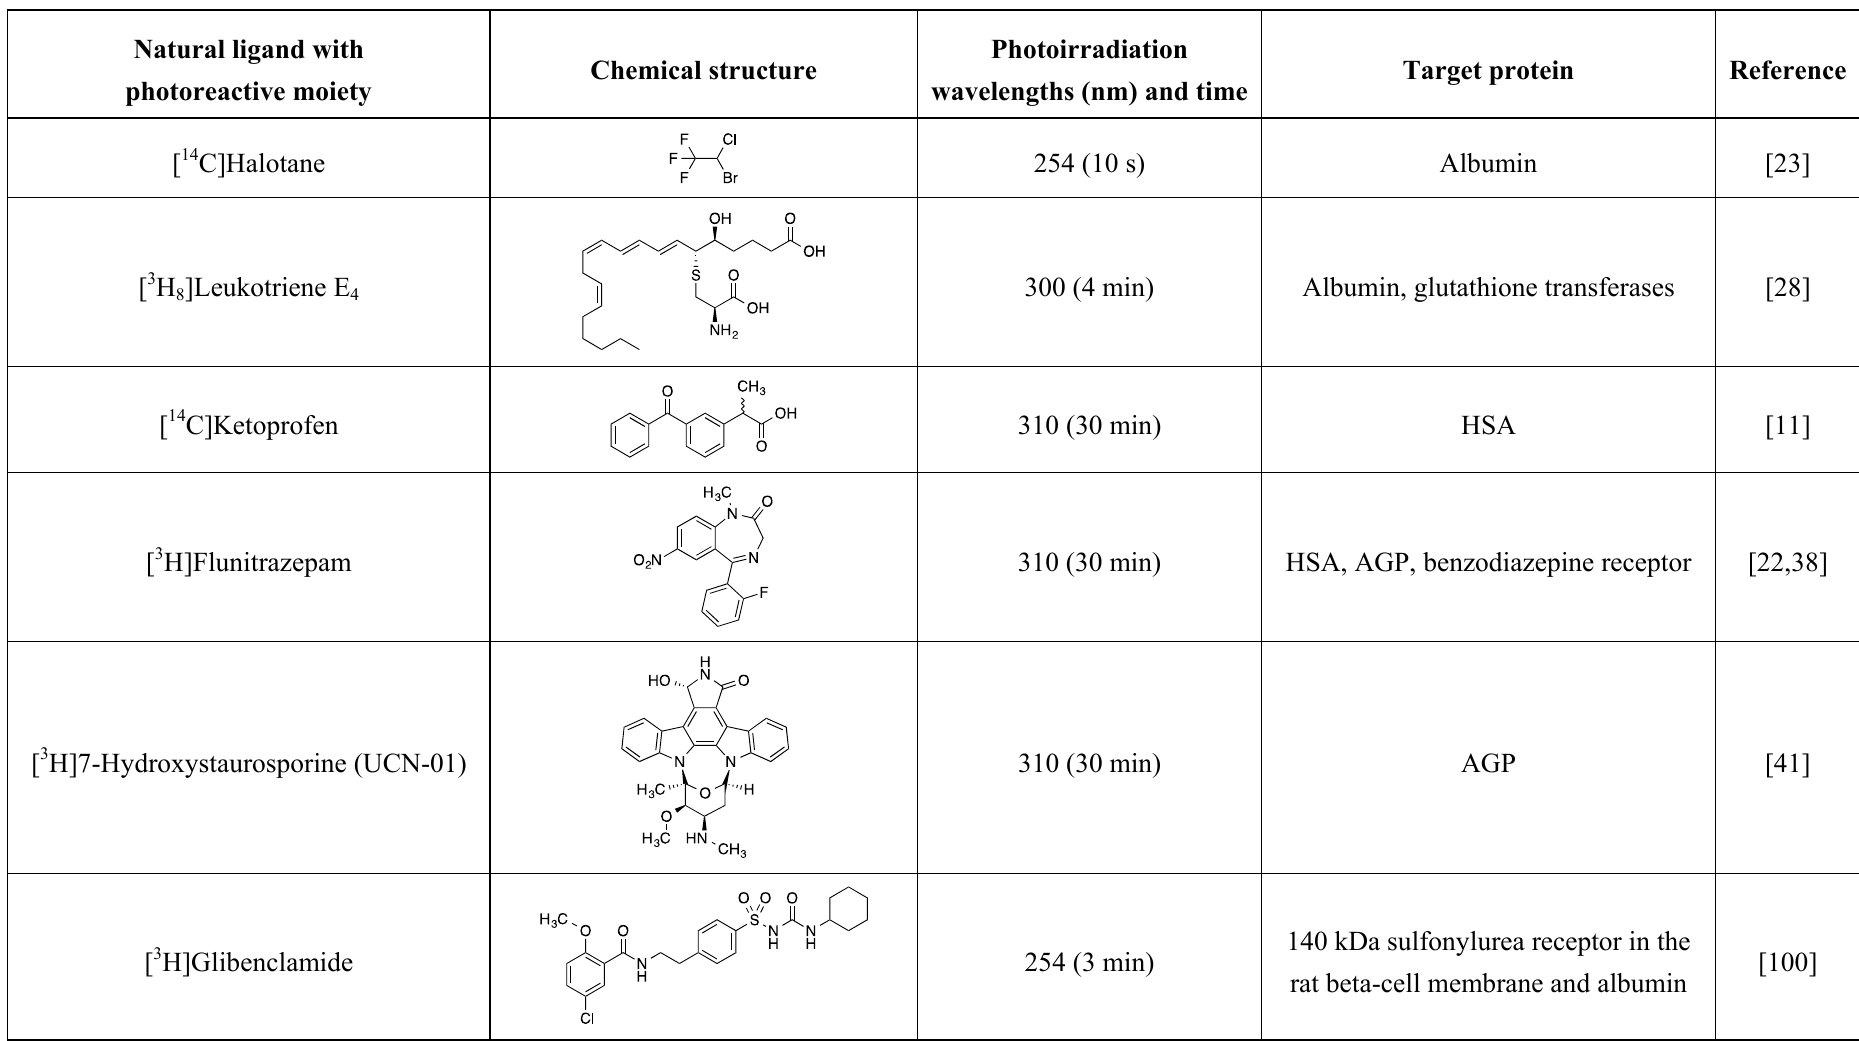
Table 1. Natural ligands with photolabile